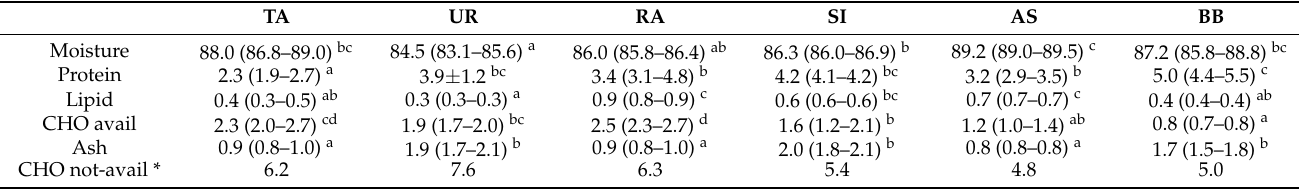
Table 4. Chemical composition of raw vegetable species.